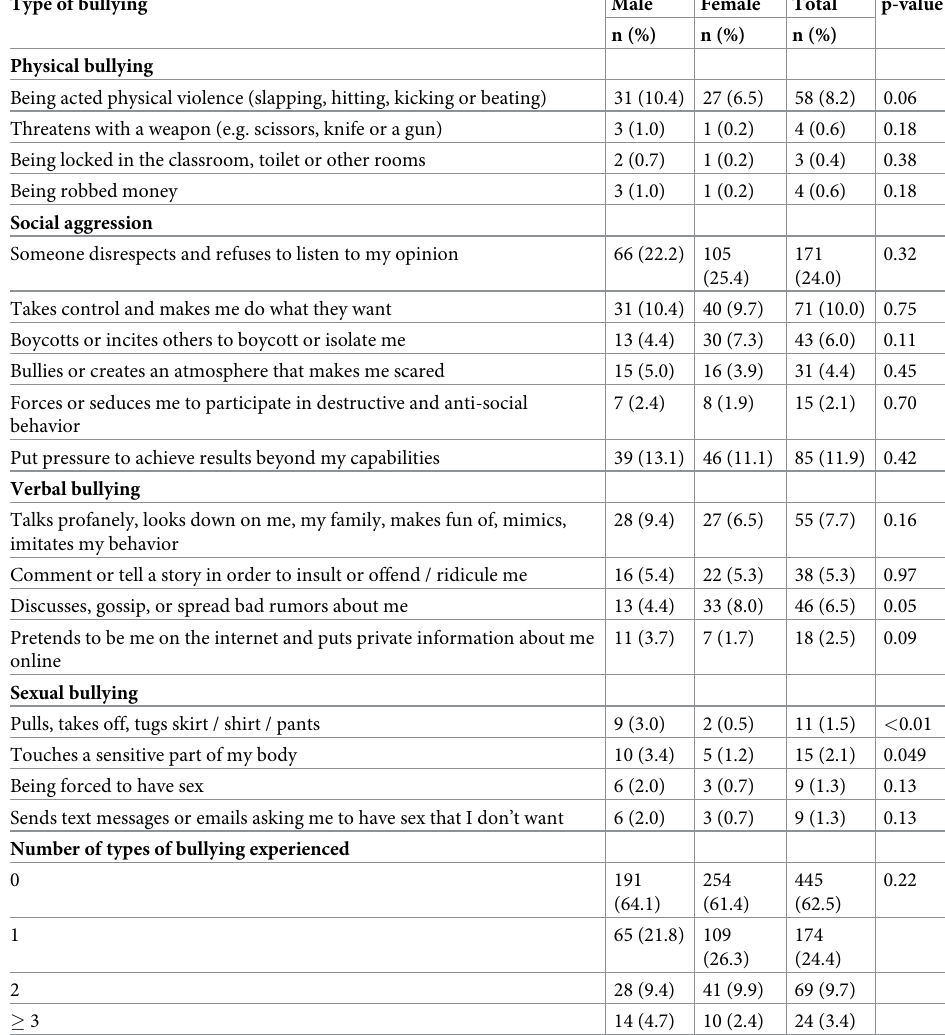
Table 2. Types of bullying in the last three